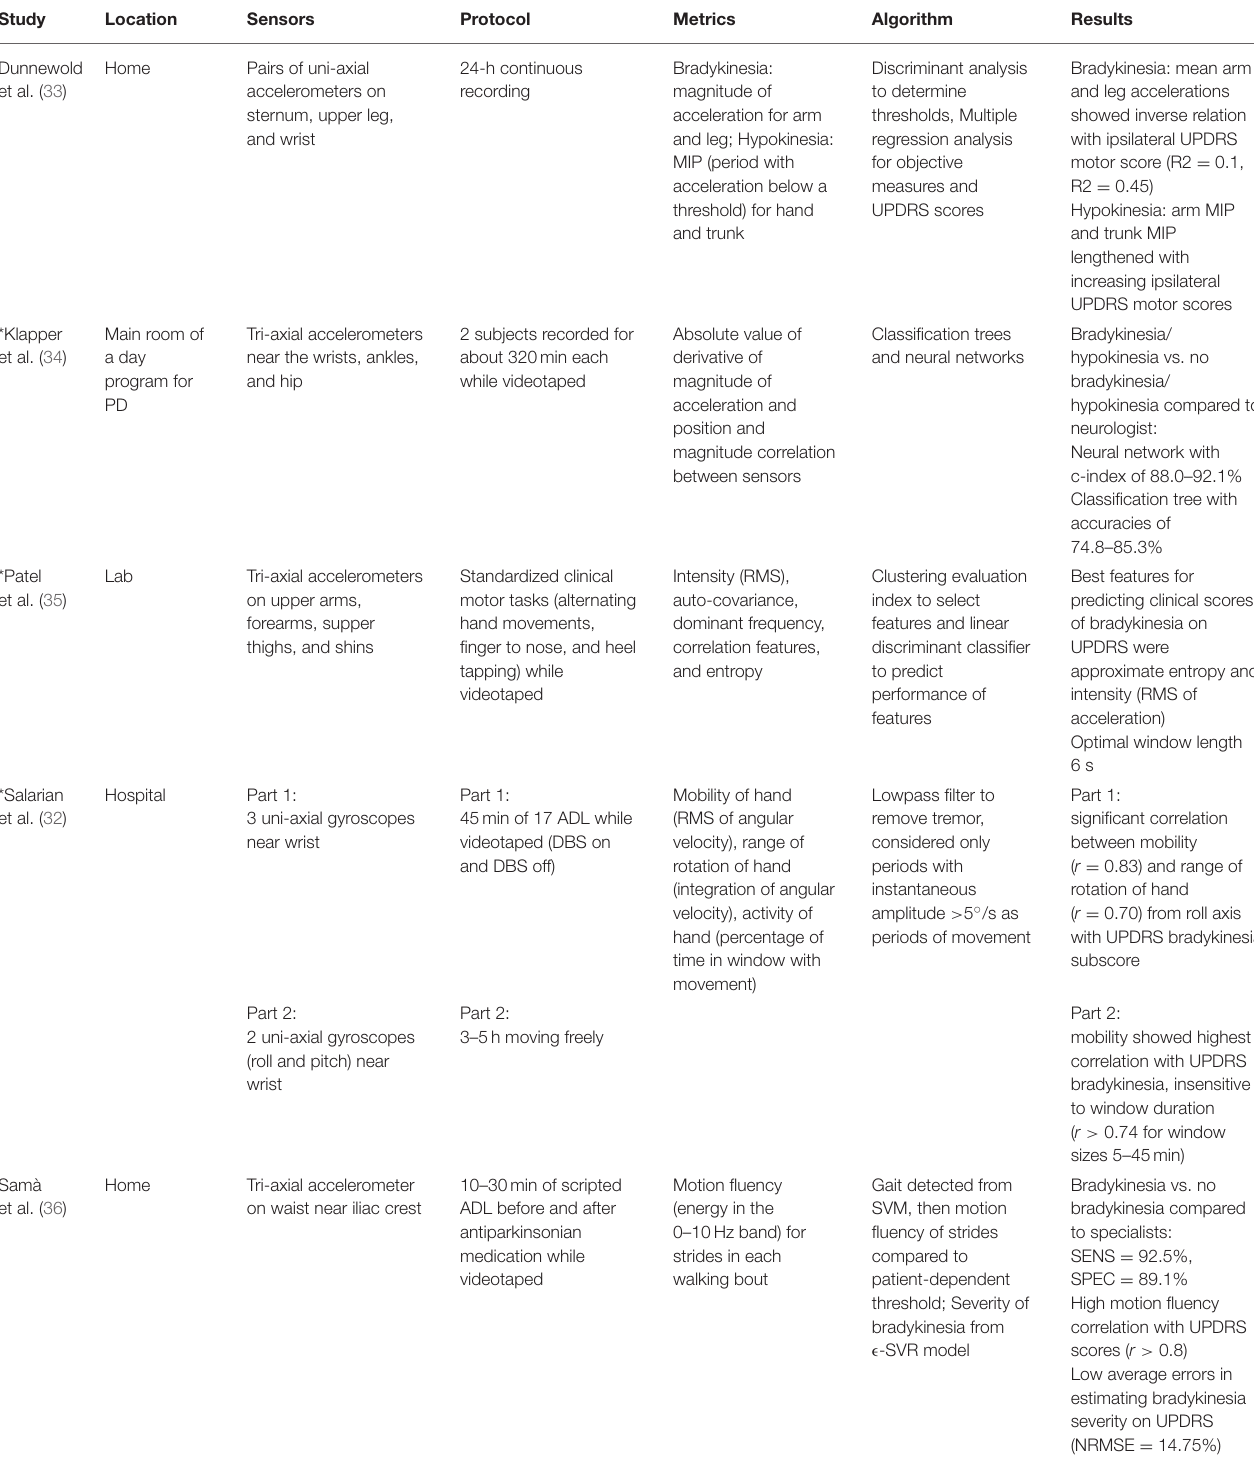
TABLE 2 | Studies on bradykinesia and/or